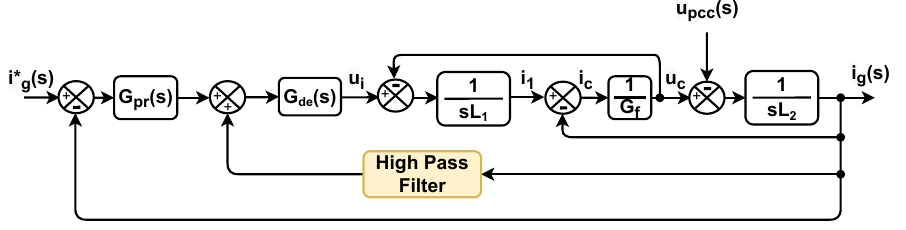
Figure 23. Control block diagram of high pass filter–based